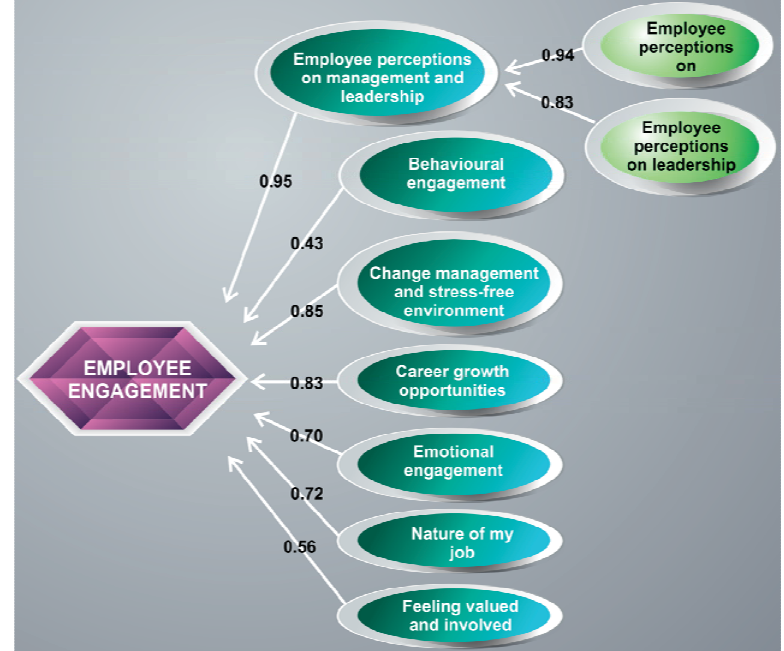
Fig. 1. Model to measure employee